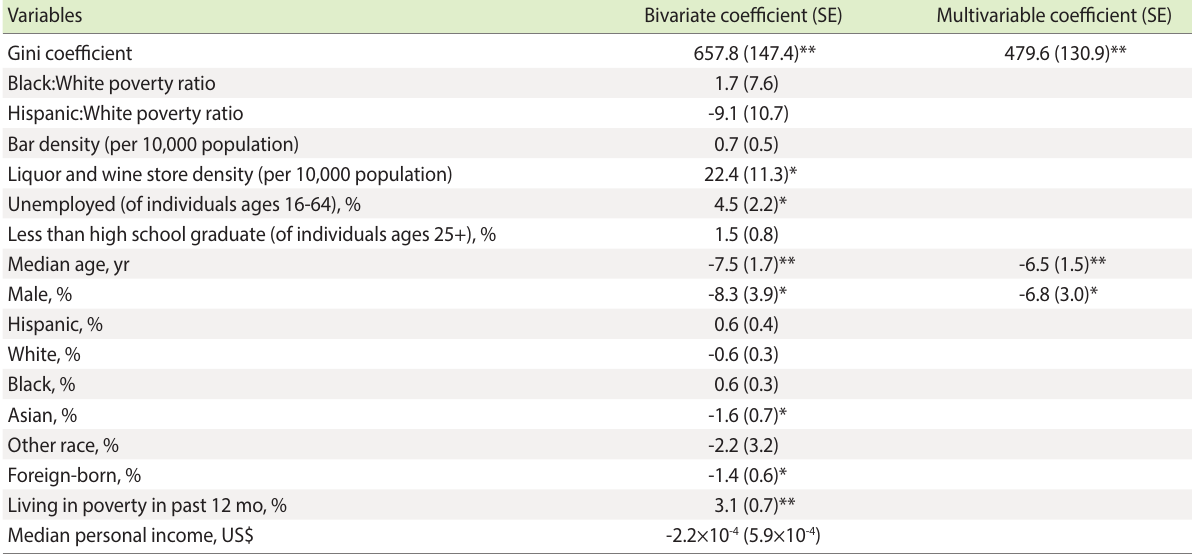
Table 2. Associations with PUMA alcohol-related emergency department hospitalization rate using linear regression models weighted by the inverse of the population of each